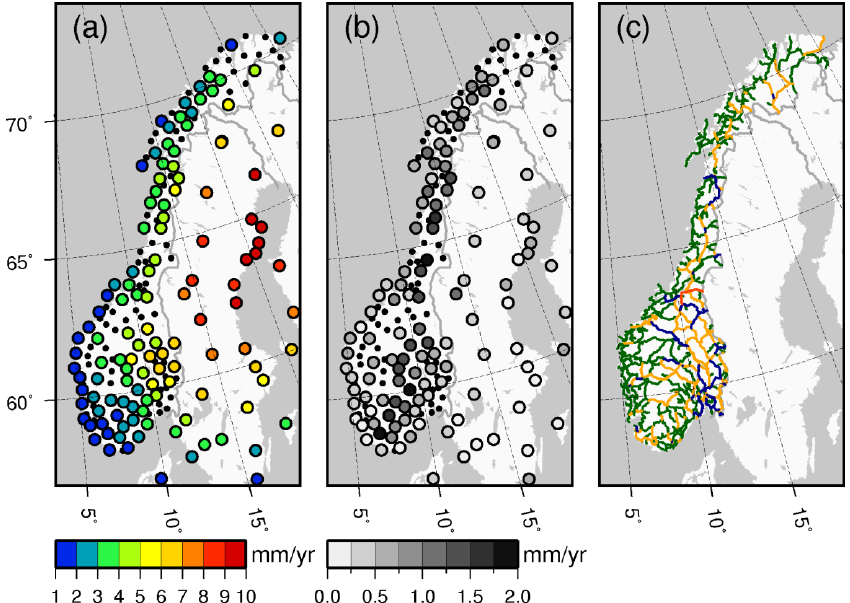
Figure 2. ( a ) Observed vertical land motion from the GPS measurements: black dots mark stations with less than three years of data, which are not included in this study as they are considered unreliable; ( b ) uncertainty on the observations (standard error); and ( c ) the levelling lines used. Red lines have been measured four times, orange lines three times, blue lines two times and green lines once. Levelling data from outside of Norway are included in our least-squares collocation solution (see below) but are not shown here.